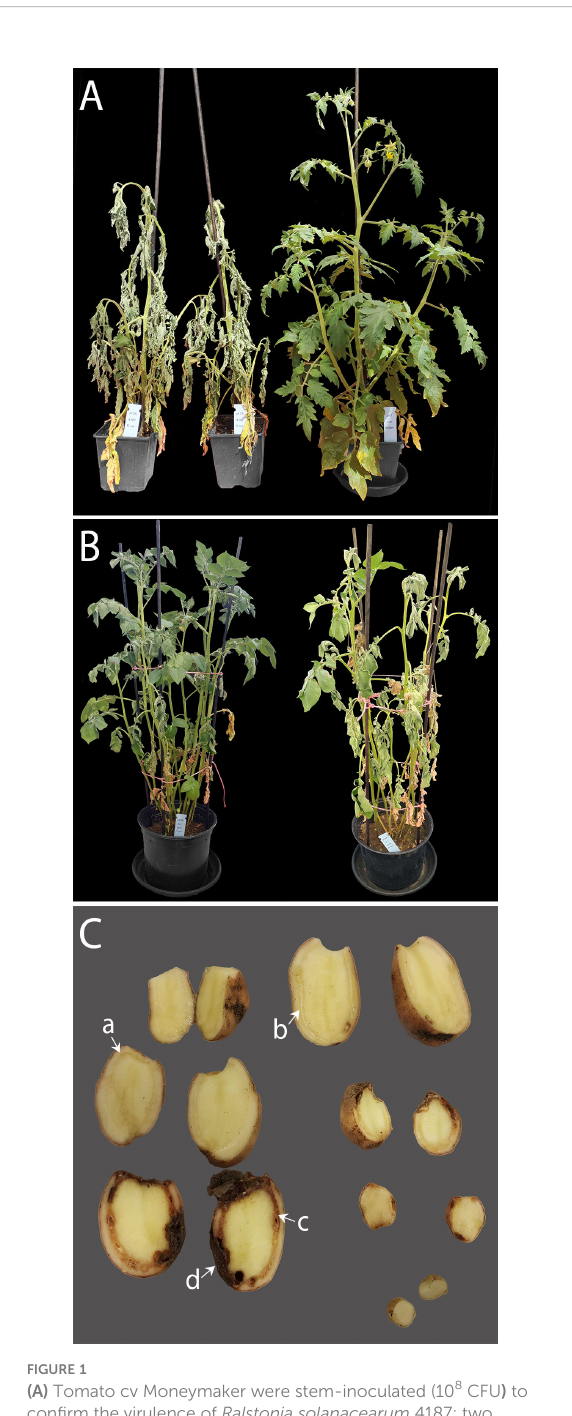
FIGURE 1 (A) Tomato cv Moneymaker were stem-inoculated (10 8 CFU ) to con fi rm the virulence of Ralstonia solanacearum 4187; two inoculated plants next to a non-inoculated control plant (right). (B) Bacterial wilt in potato cv Kondor after soil-soak inoculation with 5x10 8 CFU, left plant shows symptoms 24 dpi and right plant 35 dpi; (C) Progeny tubers of a potato plant inoculated with 5x10 9 CFU; stolon ends have been removed for analysis; tubers show typical infection symptoms of R. solanacearum in different stages of infection indicated by the arrows – the vascular ring discolors (a) and white bacterial ooze emerges (b) followed by browning of the vascular ring (c) and rotting of tuber tissue